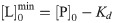
Characteristic chemical relaxation of induced-fit and conformational-selection binding.(a) In induced-fit binding, the change between the conformations P1 and P2 of the protein occurs after binding of the ligand L. The intermediate state P1L relaxes into the bound ground state P2L with rate kr, and is excited from the ground state with rate ke. (b) In conformational-selection binding, the conformational change of the protein occurs prior to ligand binding. The intermediate state P2 is excited from the unbound ground state P1 with rate ke, and relaxes back into the ground state with rate kr. (c) The dominant, smallest relaxation rate kobs of induced-fit binding is minimal at the total ligand concentration [L]0min=[P]0-Kd where [P]0 is the total protein concentration and Kd the overall dissociation constant. As a function of [L]0, the dominant rate kobs is symmetric with respect to this minimum. (d) The dominant, smallest relaxation rate kobs of conformational-selection binding has a characteristic minimum as a function of [L]0 for ke > k−, but is not symmetric with respect to this minimum. (e) The dominant rate kobs of conformational-selection binding decreases monotonically with [L]0 for ke < k−.